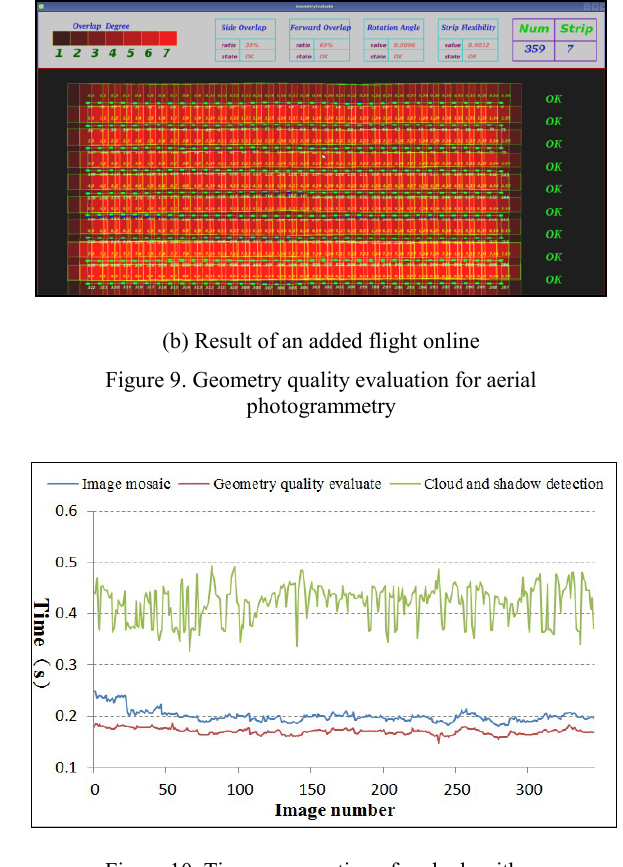
Figure 10. Time consumption of each